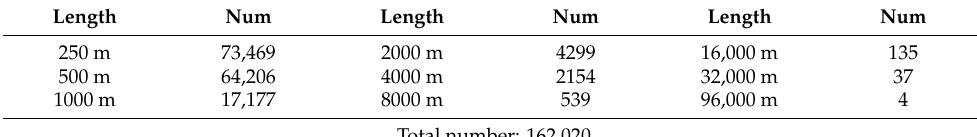
Table 2. The mobile phone base station information of the Wuhan riverside area.